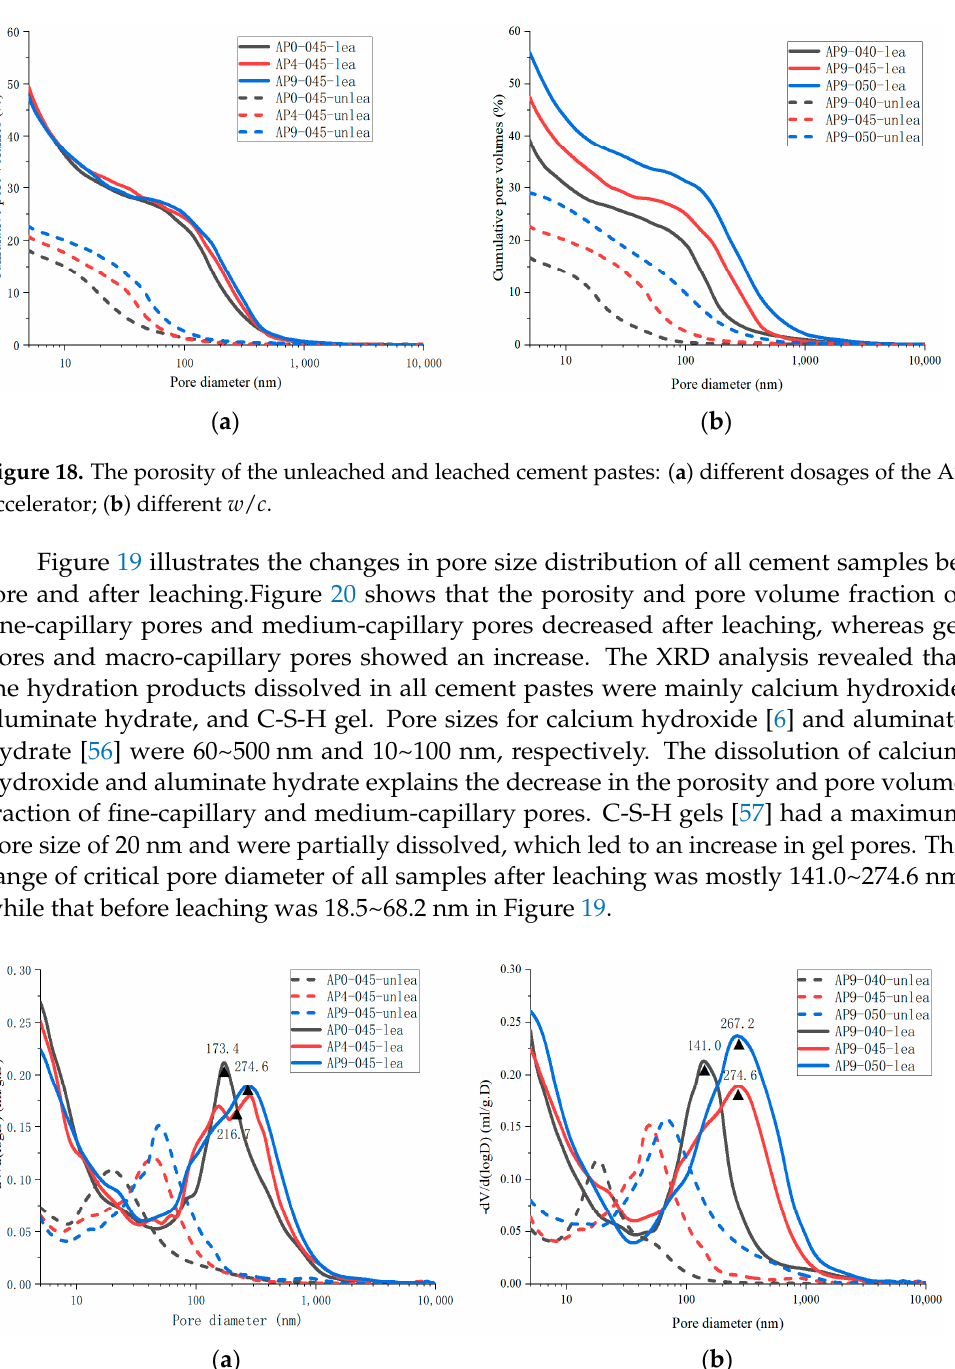
Figure 19. The pore size distribution of the unleached and leached cement pastes: ( a ) different dosages of the AS accelerator; ( b ) different w/c.